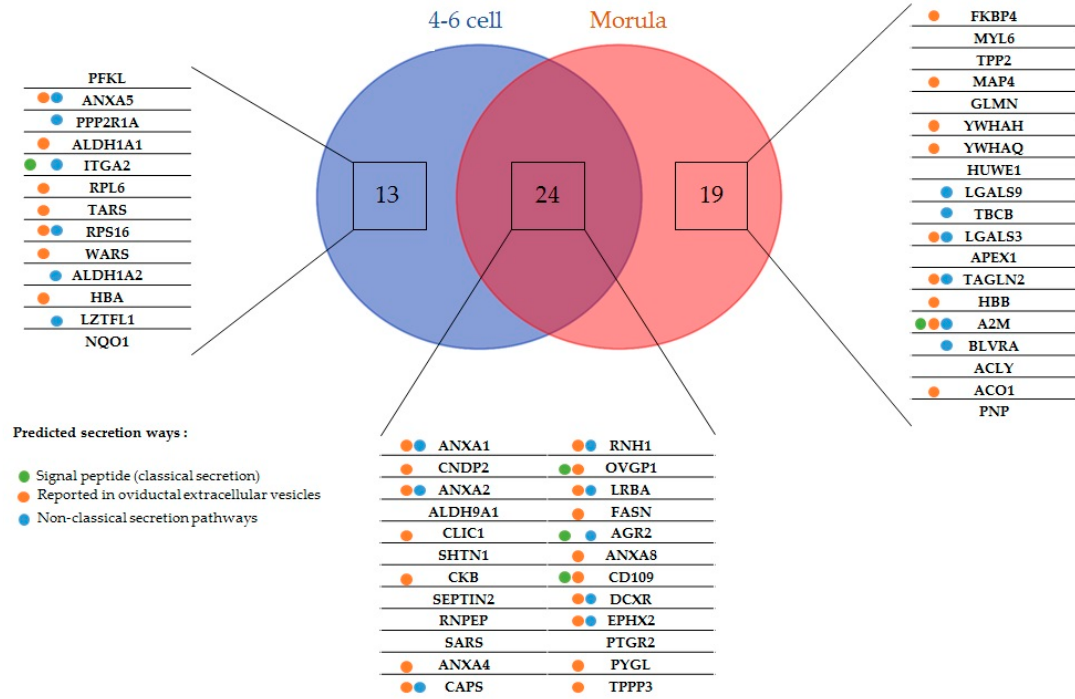
Figure 2. Embryo-interacting proteins classified according to the embryonic stage and secretion pathway. Colored spots indicate the presumed secretion pathways in oviduct epithelial cells tools. Green, proteins possessing a peptide signal and presumed to be conventionally secreted; blue, proteins predicted to be non-conventionally secreted; orange, proteins reported in bovine [9] and feline [30] oviductal exosomes.